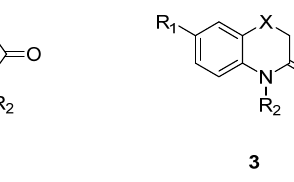
Figure 4. Strategies for structural modifications of natural safener sanshools and the as-obtained candidates with high activities ( 2k , 4k ; 3g , and 1 ).